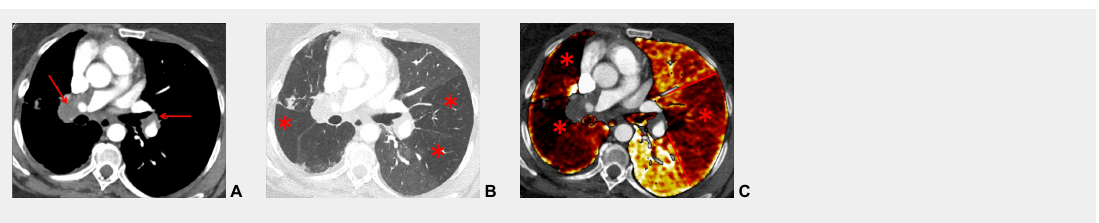
Figure 2 Chronic thromboembolic pulmonary hypertension (CTEPH). Vascular ( A ) and parenchymal ( B ) signs of CTEPH with proximal marginal occlusion (arrows) and mosaic pattern (stars). Functional information simply added with triangular perfusion defects (stars) on the iodine maps ( C